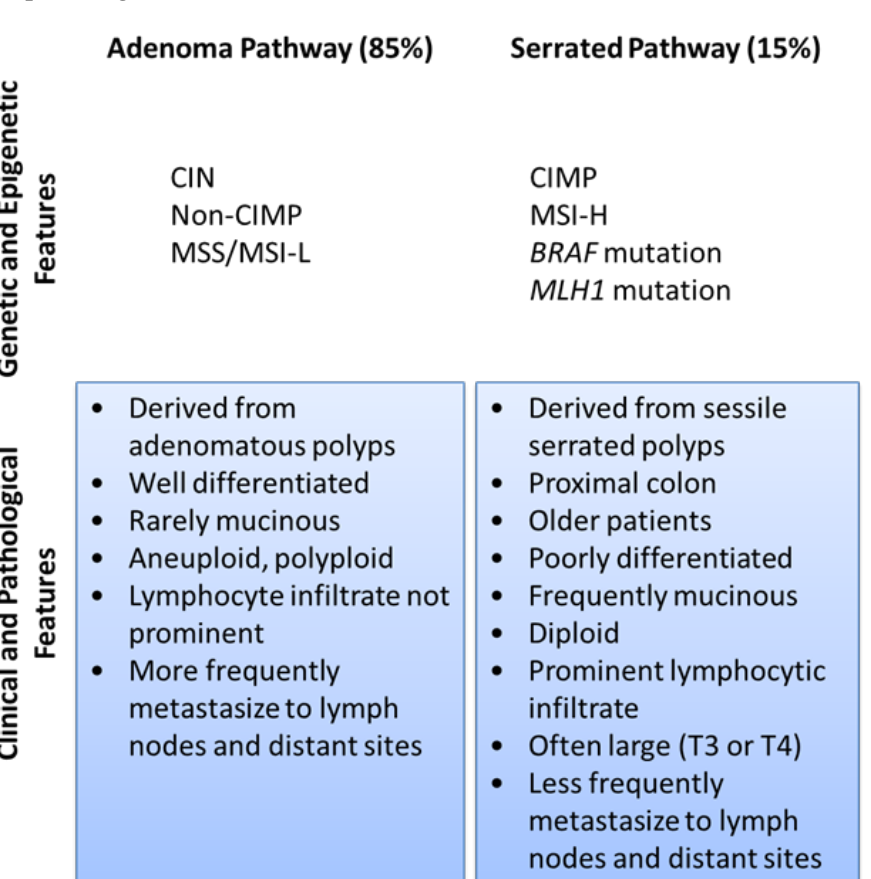
Figure 1. Classification of CRC by pathogenic pathway. The classical pathway involves a progressive accumulation of mutations due to chromosomal instability as an adenoma develops into adenocarcinoma. Serrated polyps, which are thought to develop from hyperplastic polyps, are generated due to microsatellite instability and/or high levels of CpG island methylation. The adenocarcinomas that emerge from that pathway have distinct clinical and pathological features.